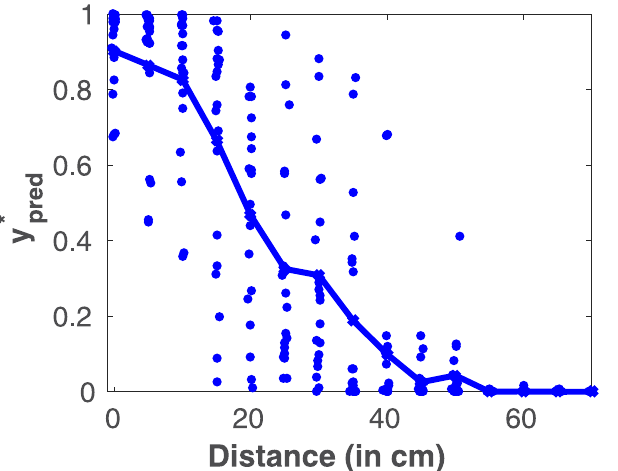
Fig 2. PPS as optimal impact utility prediction for baseline parameters. Blue dots—20 for each distance—are individual predictions (samples) of y � . Blue line—mean of 20 repetitions. Parameters used are in Table 1. See S1 Fig pred for a version with FN = FP =